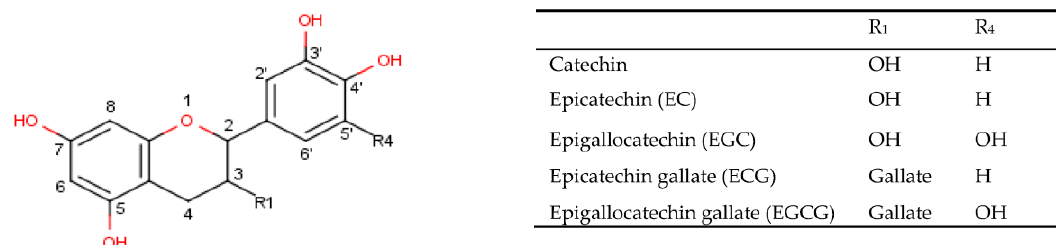
Figure 1. Structure of the main catechins found in green tea.